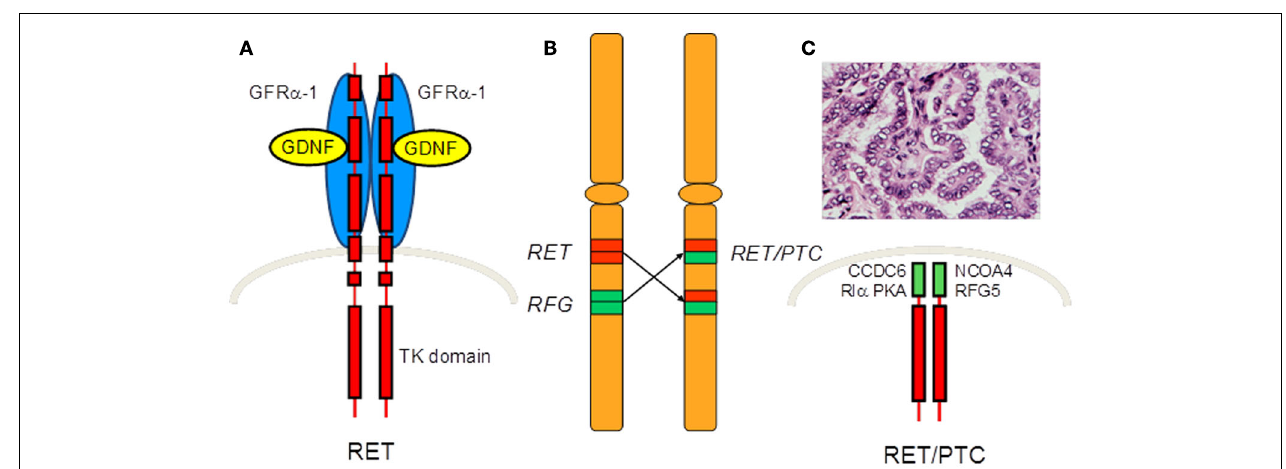
rearrangements result in the in-frame fusion of RET intracellular domain coding region with the 5 (cid:2) end of heterologous genes.The resulting chimeric sequence codes an oncoprotein, called RET/PTC, that drives the development of